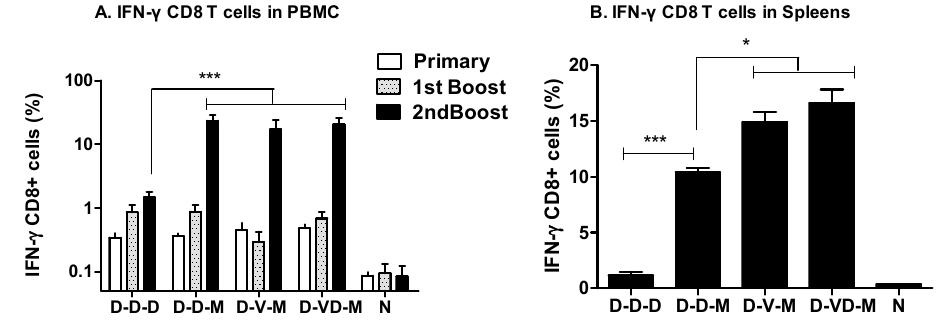
Figure 3. Boost with rMVA vaccine enhances IFN- γ positive CD8 T cell responses. ( A ) IFN- γ CD8 T cells in blood by an intracellular cytokine staining assay (ICC). PBMCs from the control and immunized mice were isolated at 12 days after each immunization. CD8 + T cells expressing intracellular IFN- γ in response to the gp120 V3 loop MHC-I peptide (ICC) was identified in a FACS Calibur. The average frequency of gp120-specific CD8 + T cells at primary and booster immunizations is shown in the histogram. The bars indicate values of standard variations ( n = 5); ( B ) IFN- γ CD8 T cells in spleens by ICC. After 14 days second boost, spleen cells were stimulated using a pool of peptides. Groups are the same as described in the Figure 2 legend. ***: p < 0.001, *: p < 0.05 between the comparing groups after second boost.